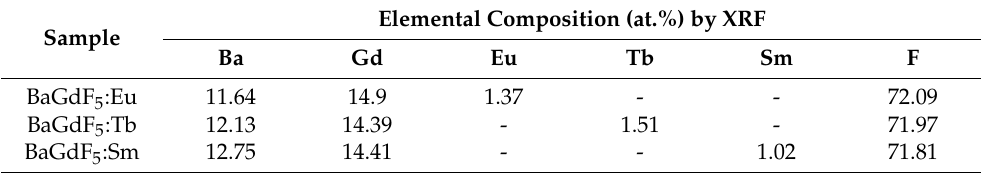
Table 1. Elemental composition of the samples measured by